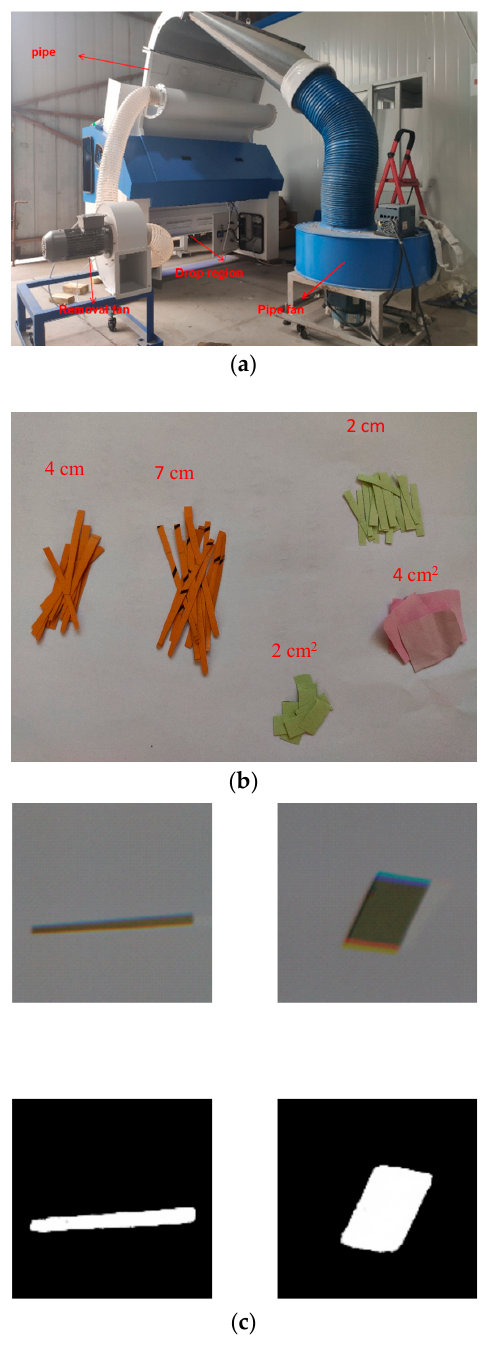
Figure 13. Standard size test. ( a ) The experiment machine; ( b ) test samples and their corresponding sizes; and ( c ) original image and its segmentation results. Table 7. The statistics estimation of standard size